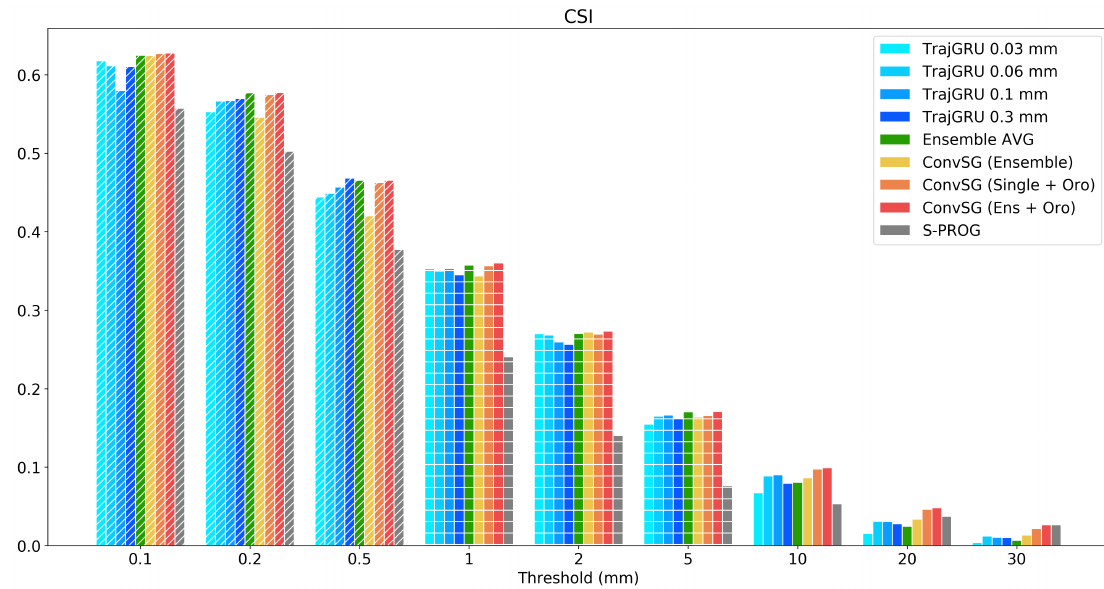
Figure 10. CSI score on test set. The dashed, squared, and plain patterns in the bars represent the three sets of light, medium, and heavy precipitation thresholds,